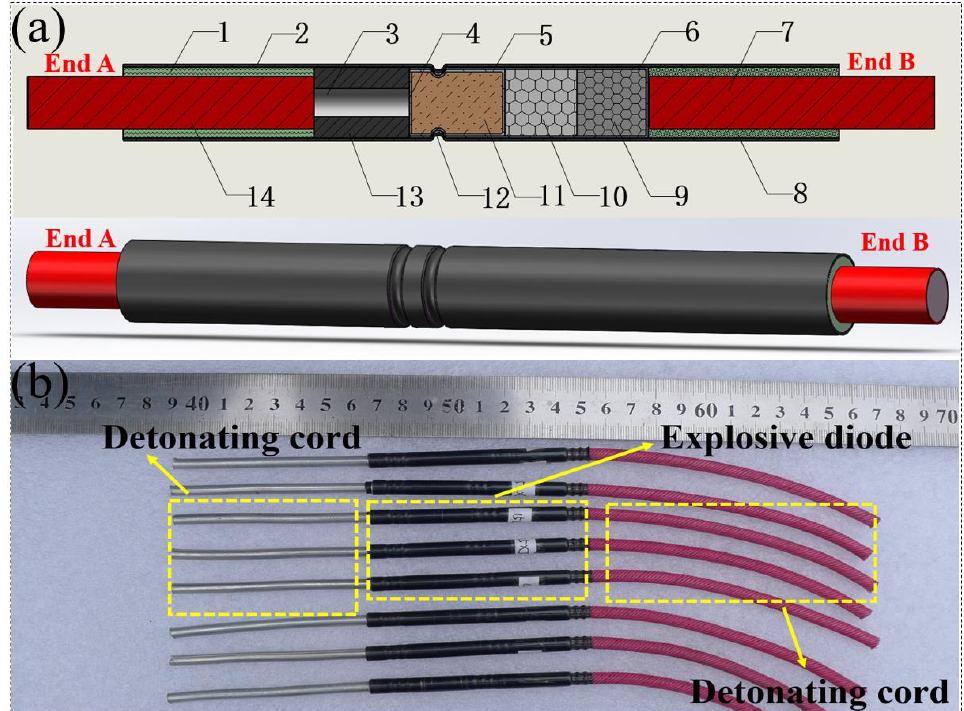
Figure 2. The unidirectional explosive element (explosive diode), ( a ) schematic, 1 and 8 — Sealing element, 2 — Metal shell, 3 — Quenching channel, 4 — Sealing wax paper, 5 — Excitation setting, 6 —